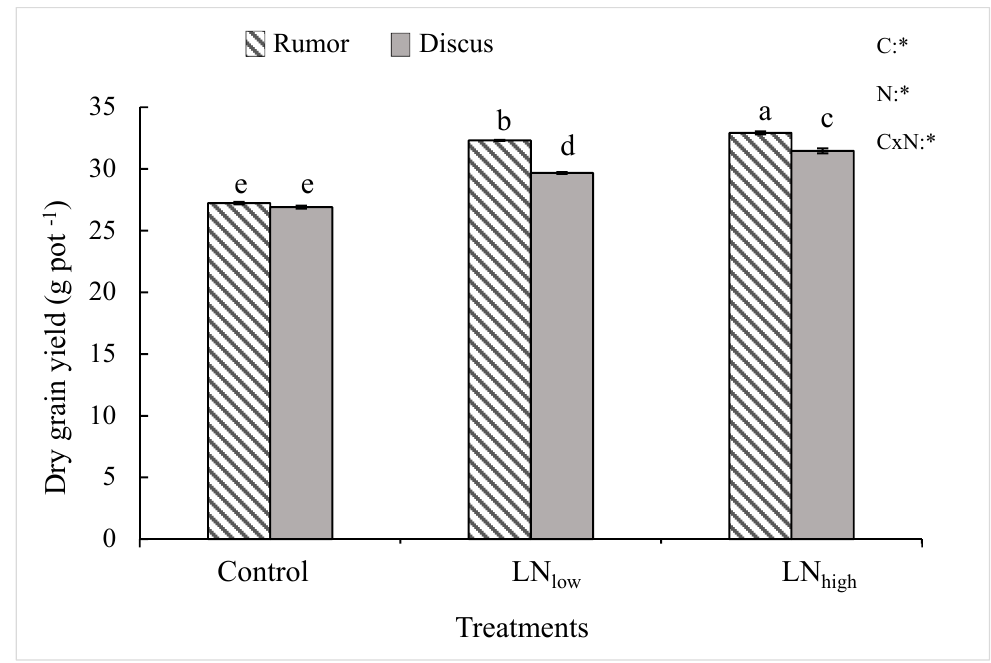
Figure 1. Total grain yield (g DW pot -1 ) in response to late application of N fertilizers (Control, LN low , LN high ) for two cultivars Rumor and Discus. Bars represent mean values ± SE ( n = 3). Different small letters indicate significant differences between all treatment combinations ( p ≤ 0.05); Two-way ANOVA results are shown in the upper right corner of the diagram. C: cultivar; N: different fertilizer treatment; CxN: Interaction between cultivar and different fertilizer treatment; *: significant effect.